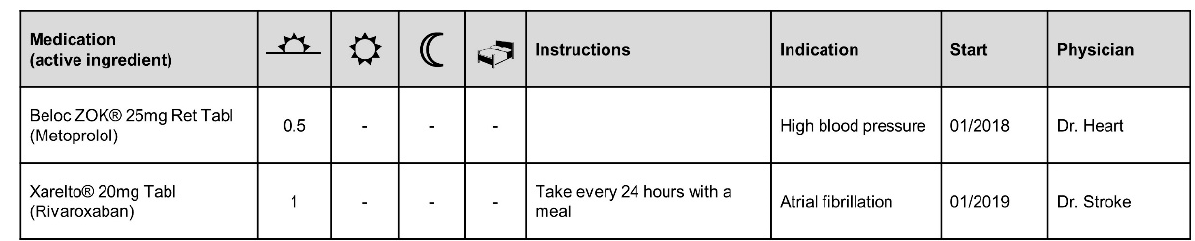
Figure 4. Illustrative medication chart of the adherence reporting form with icons for the time of the day.